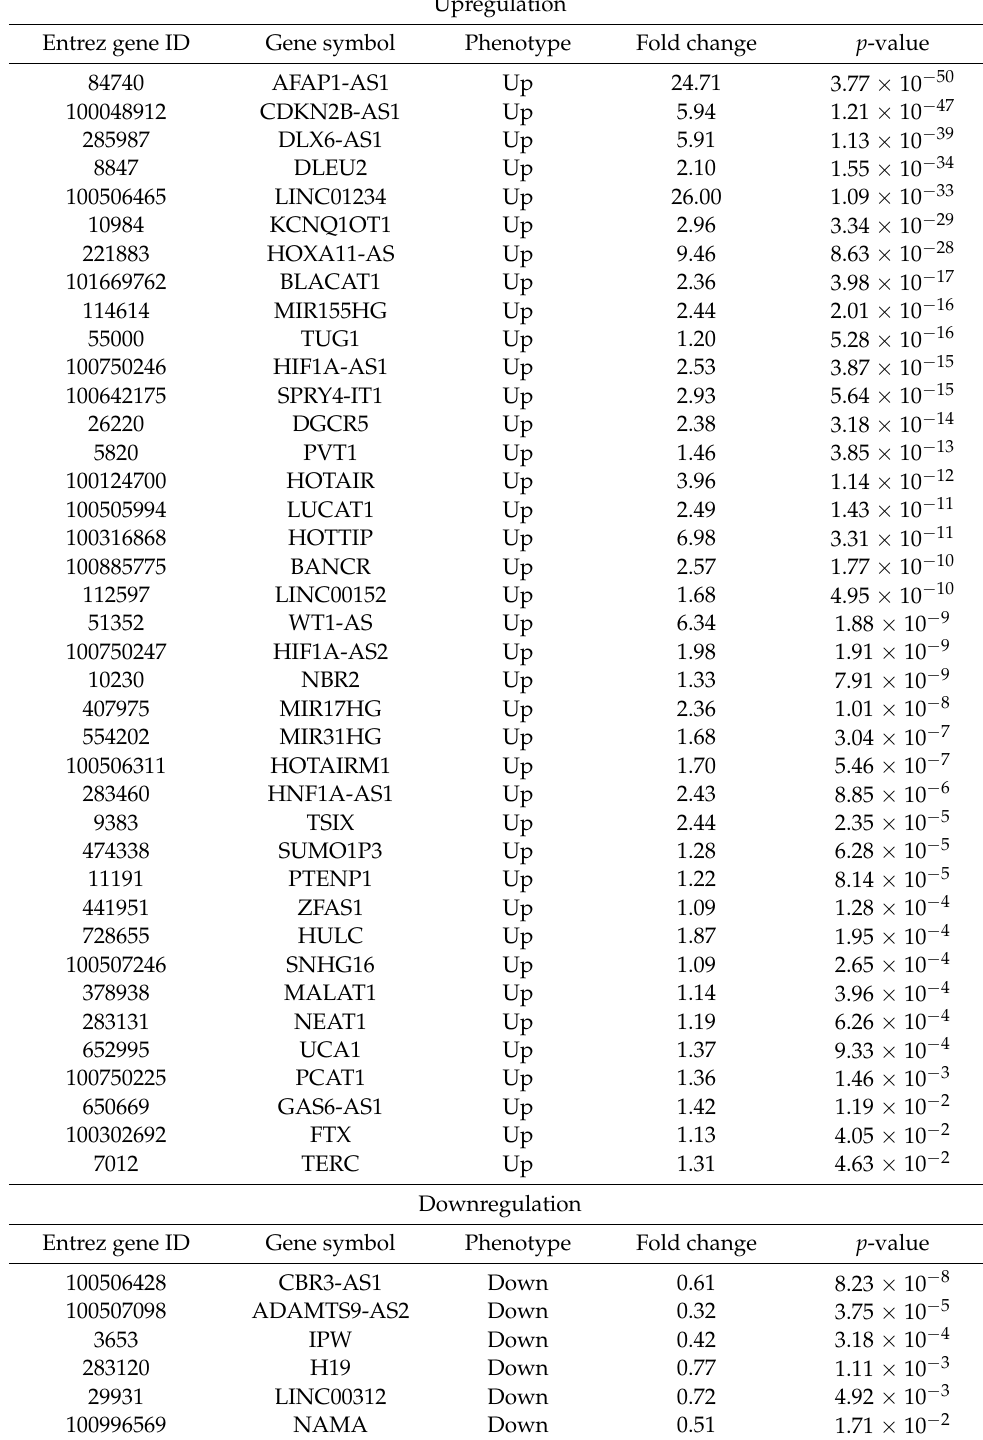
Table 2. Significantly differentially expressed lncRNAs in